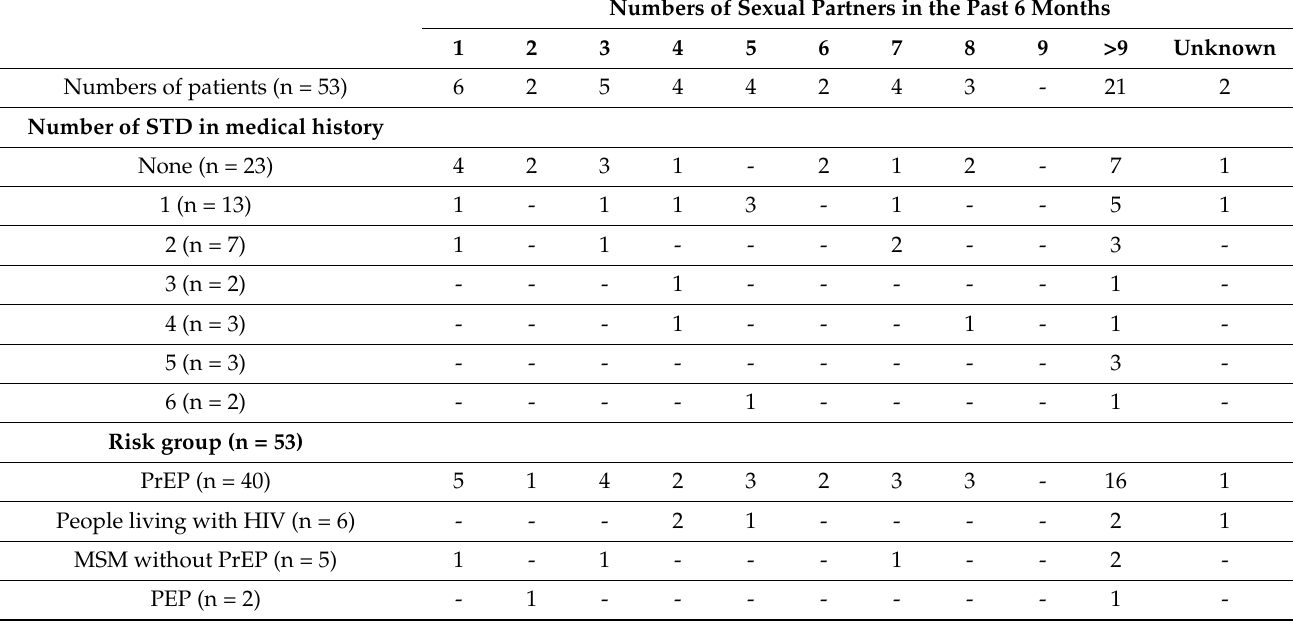
Table 1. Sexual and demographic characterization. Numbers of Sexual Partners in the Past 6